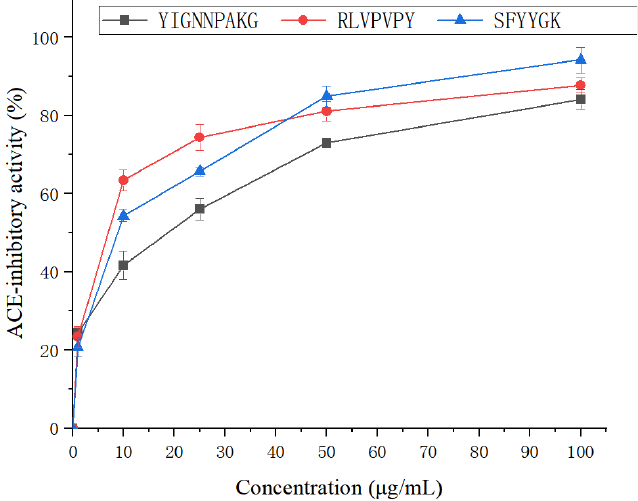
Figure 4. The ACE-inhibitory activity of the three candidate peptides (SFYYGK, RLVPVPY, and YIGNNPAKG).